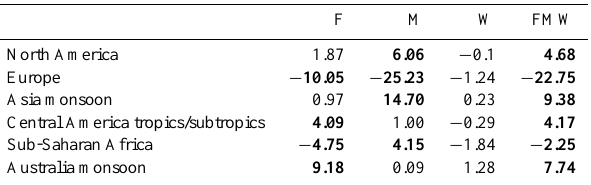
Table 2. Difference in burned area between 200 and 8000calyrBP (100–199 minus 7900–7999) relative to the 8000calyrBP state in [%] for different regions and experiments (F: fuel availability vary- ing; M: moisture varying; W: wind speed varying; FMW: fuel avail- ability, moisture and wind speed varying – control simulation). Re- gions are chosen according to Marlon et al. (2013). Significant val- ues (confidence level higher than 95% determined with a Student t test) are shown in bold. F M W FMW North